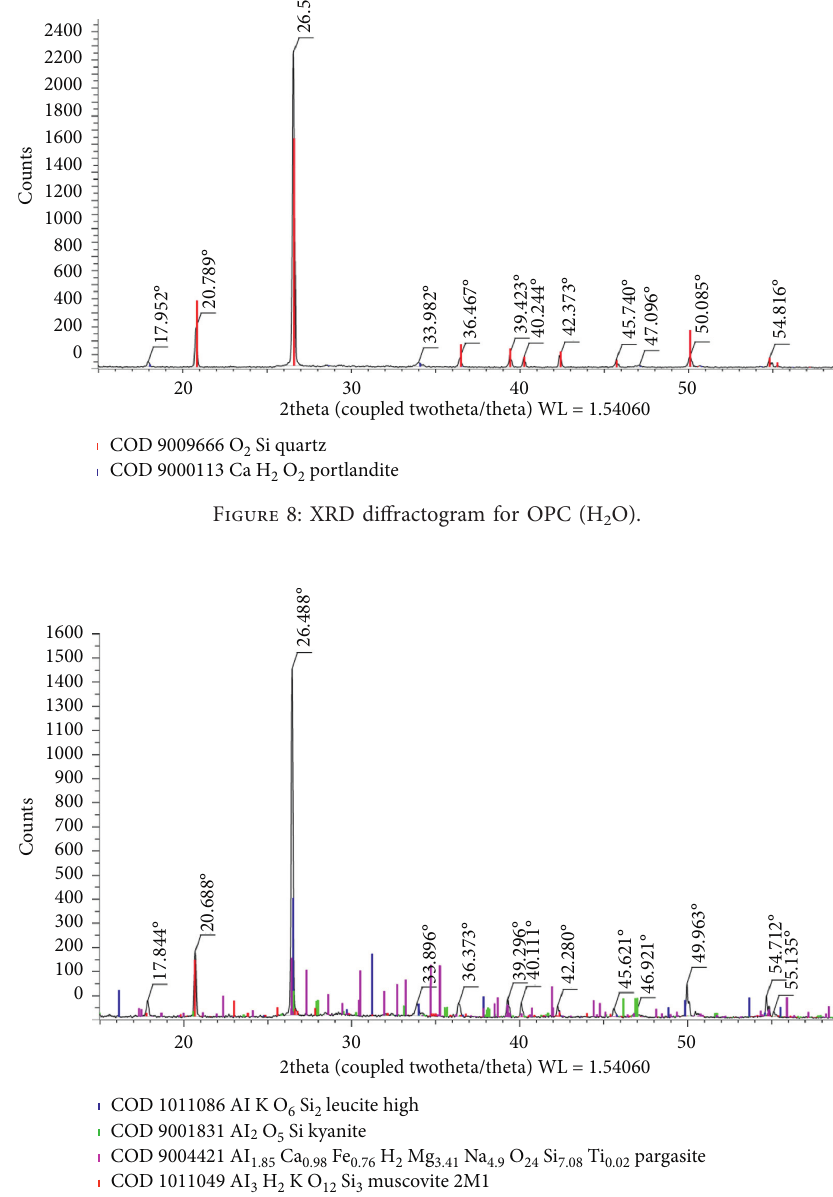
Figure 9: XRD diffractogram for OPC